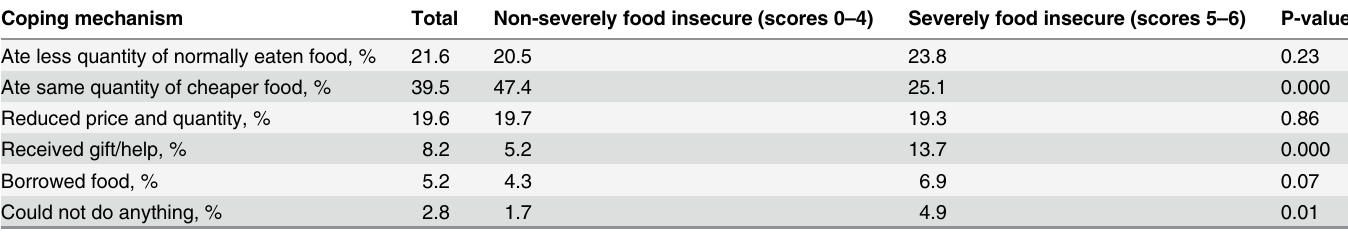
Table 4. Coping mechanisms employed by Palestinian refugee households who reported that the food that they had did not last, and they did not have money to buy more. Coping mechanism